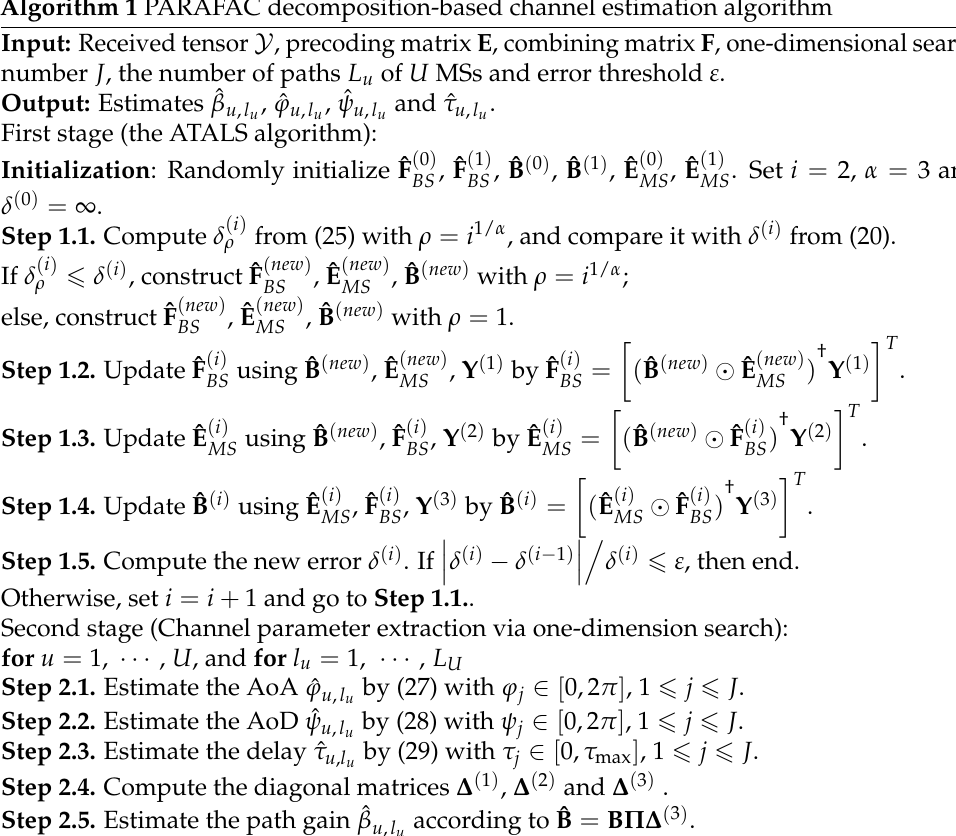
Algorithm 1 PARAFAC decomposition-based channel estimation